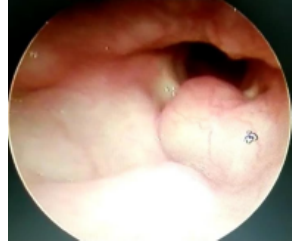
Figure 9. Saccular cyst arising from left